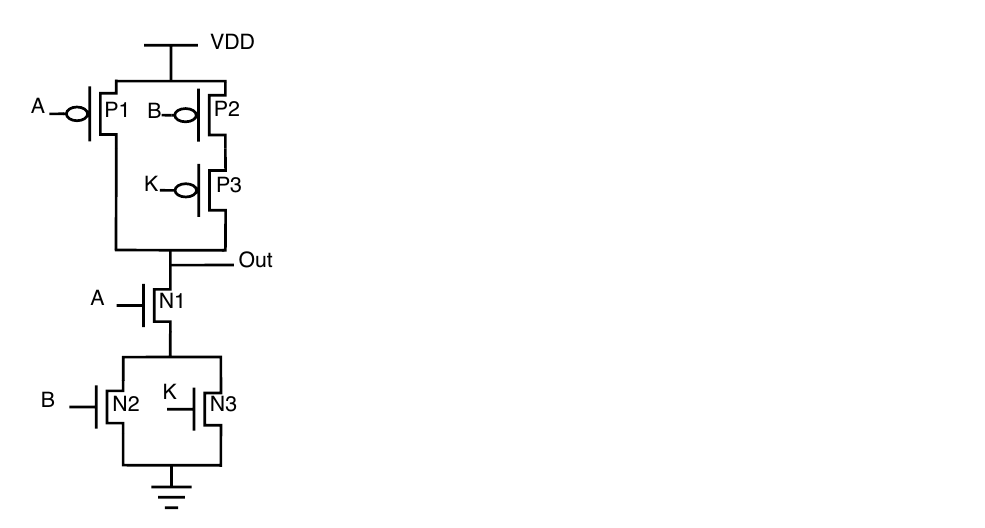
Figure 11. XOR PT: with buffer.